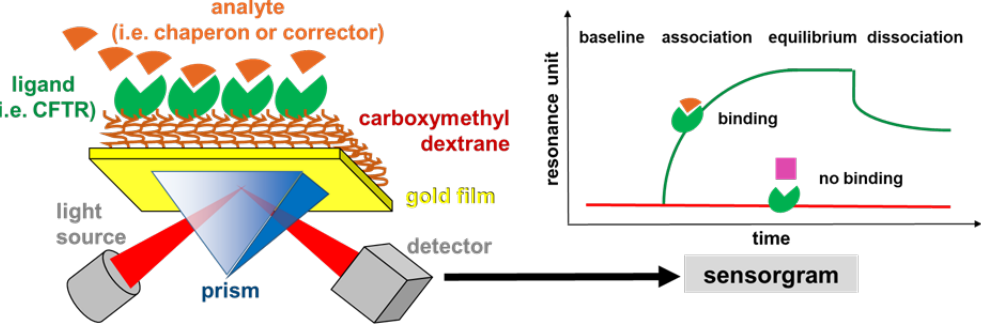
Figure 3. Schematic representation of surface plasmon resonance (SPR) technology. One of the two binders is immobilized onto the sensorchip (ligand), while the other (analyte) is injected into the microfluidic system. When occurring, the analyte/ligand interaction changes the refractive index of the gold surface to which the ligand is immobilized, providing label-free transduction of the binding event that is presented as a sensorgram, consisting in a real-time graph of the response units against time. In a sensorgram, three phases can be identified: association, equilibrium binding and dissociation.